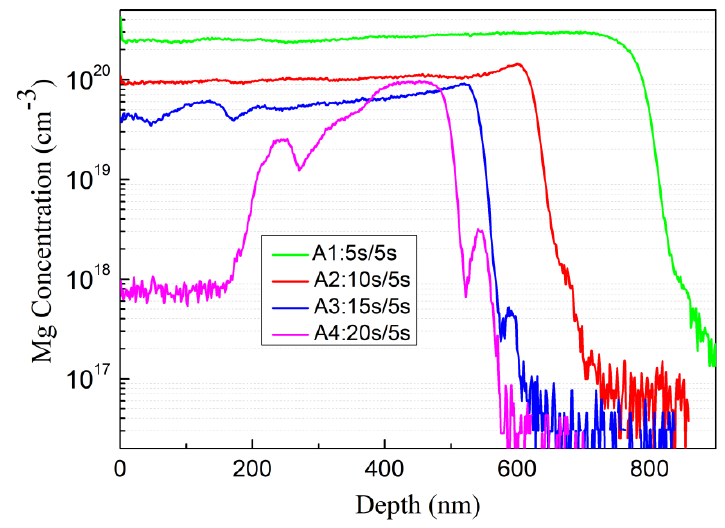
Figure 4. SIMS profile, Mg doping concentration of sample A1, A2, A3 and A4.